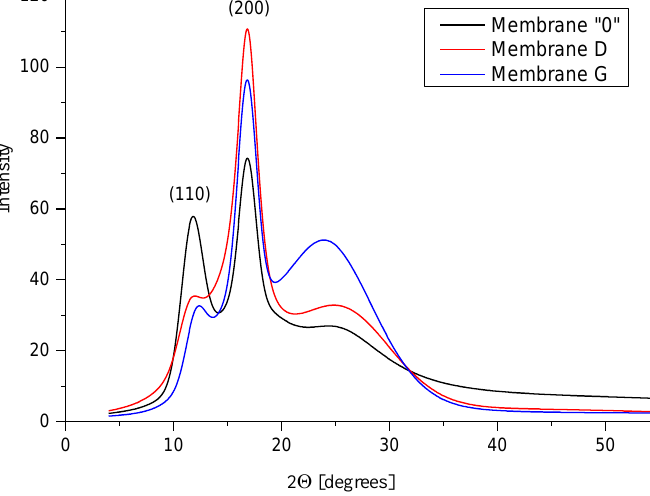
Figure 9. X-ray di ff ractograms of Membrane 0 (pure PAN) and the pure rGO (for better visualization, Figure 9. X-ray diffractograms of Membrane 0 (pure PAN) and the pure rGO (for better the di ff raction curves have been shifted along the ordinate axis). visualization, the diffraction curves have been shifted along the ordinate axis).